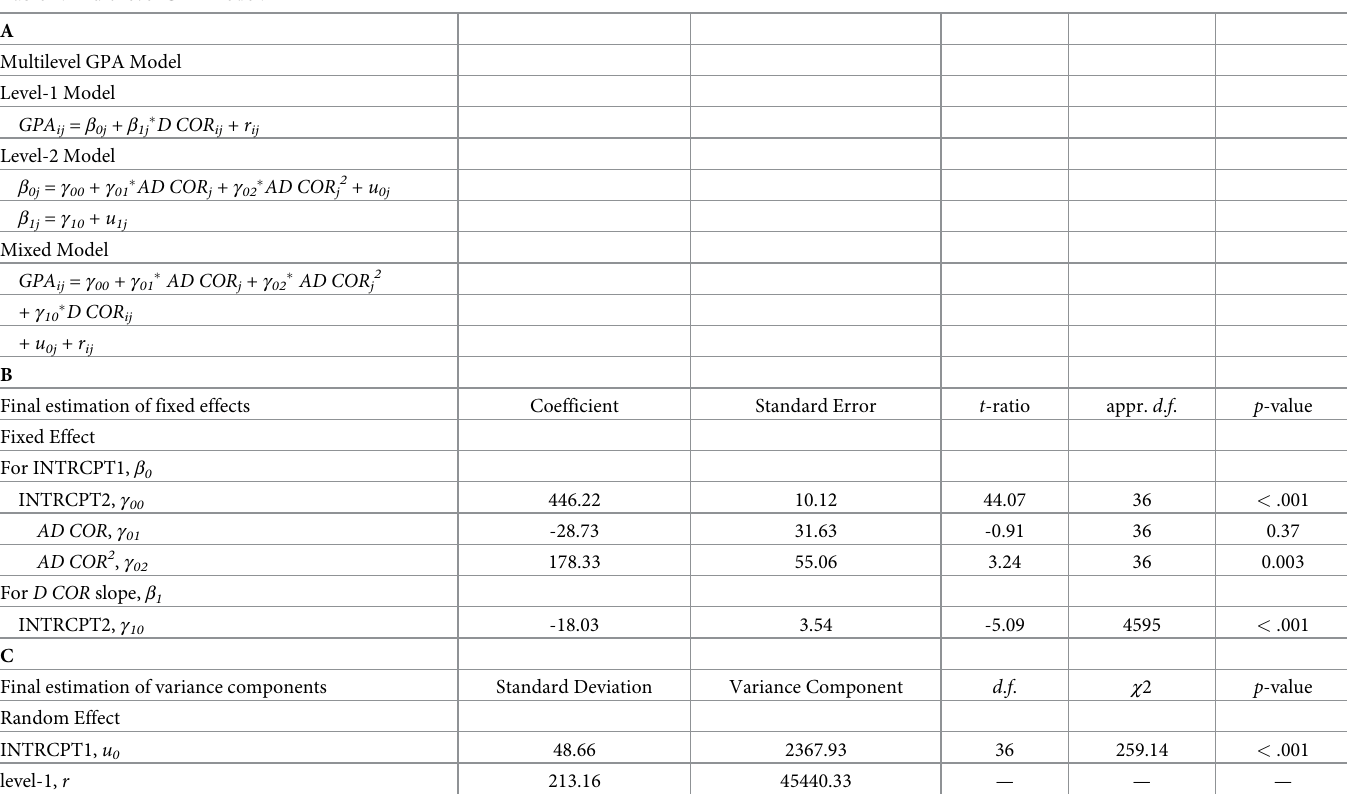
Table 4. Multilevel GPA